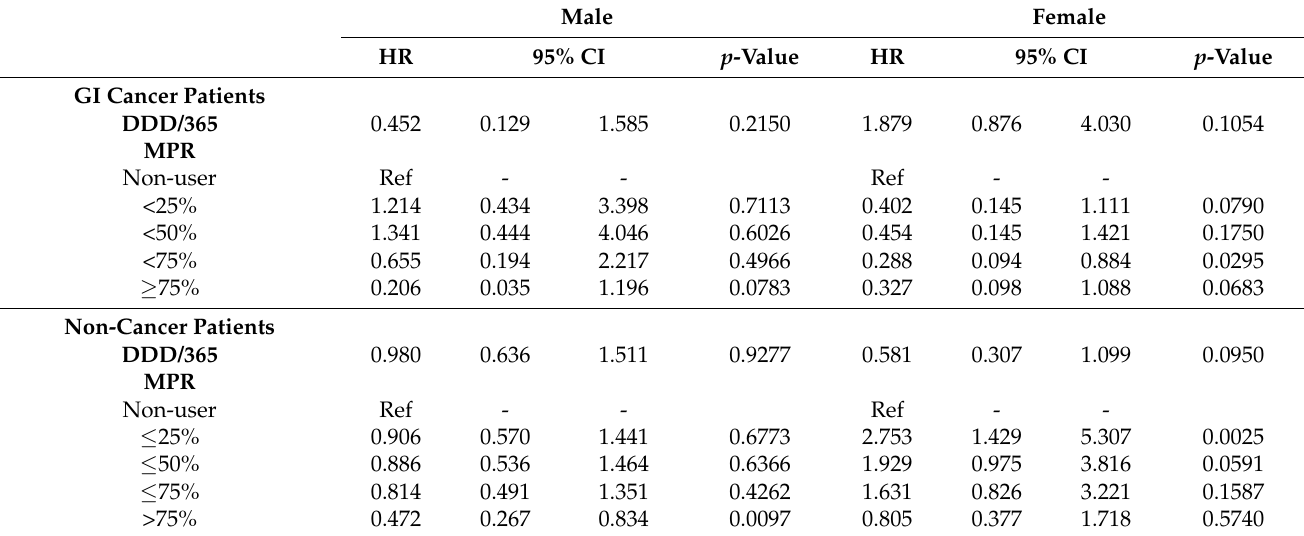
Table 3. Association between continued post-diagnostic statin use and mortality by